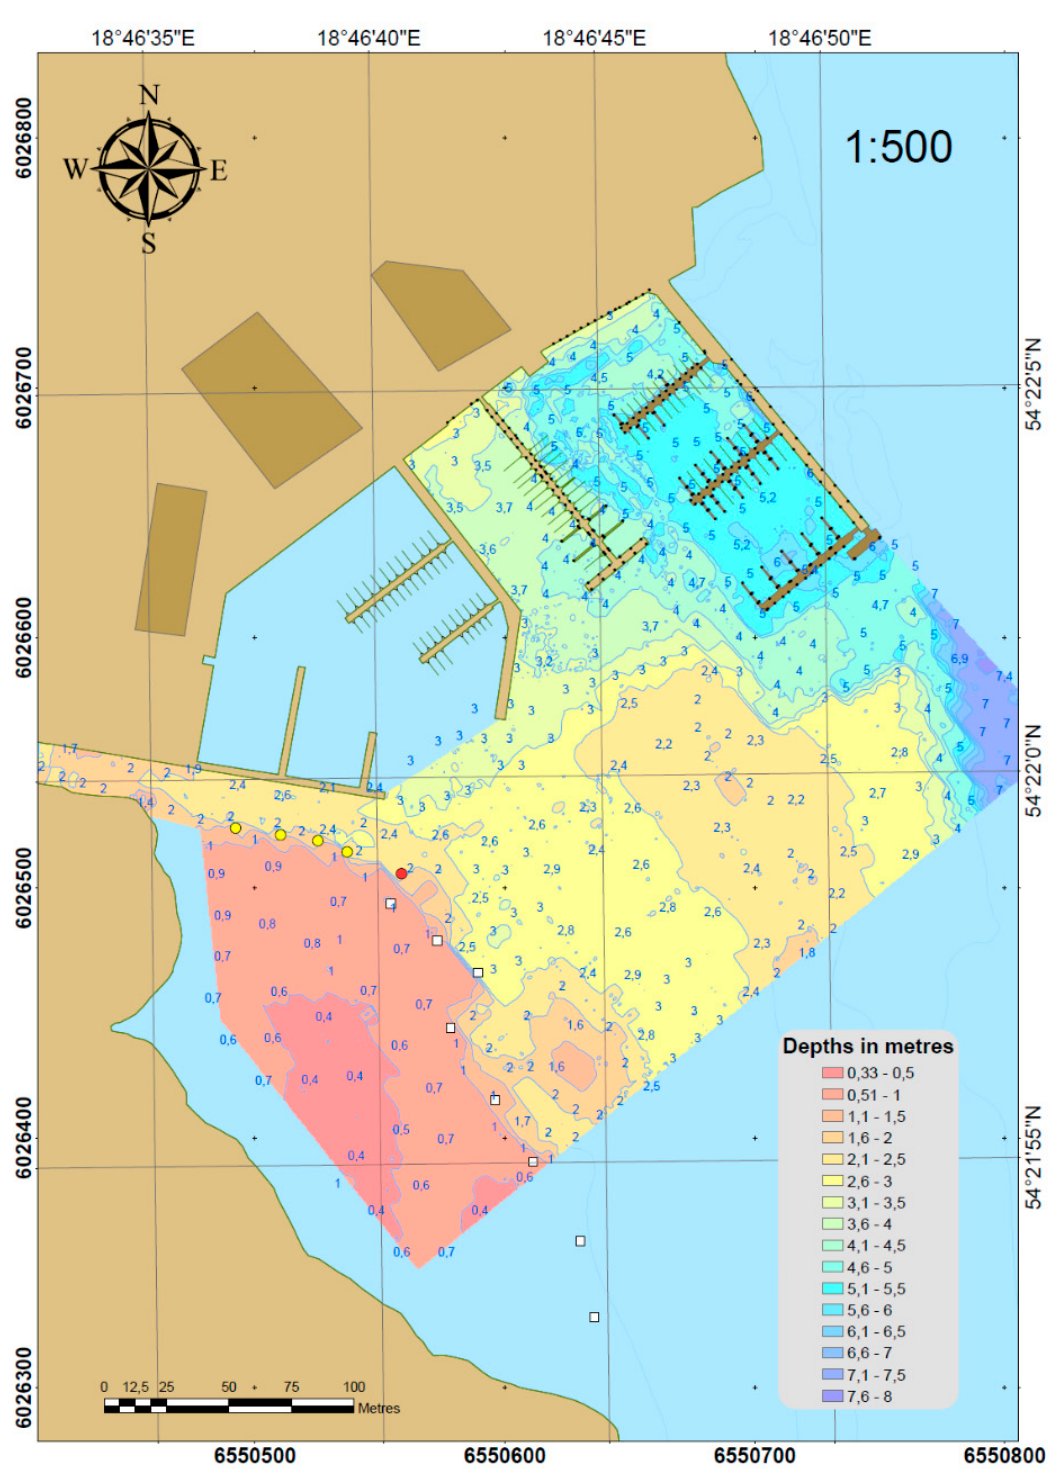
Figure 12. Navigational chart of the approach fairway to the National Sailing Centre at the Gda ń sk University of Physical Education and Sport (NSC-GUPES).